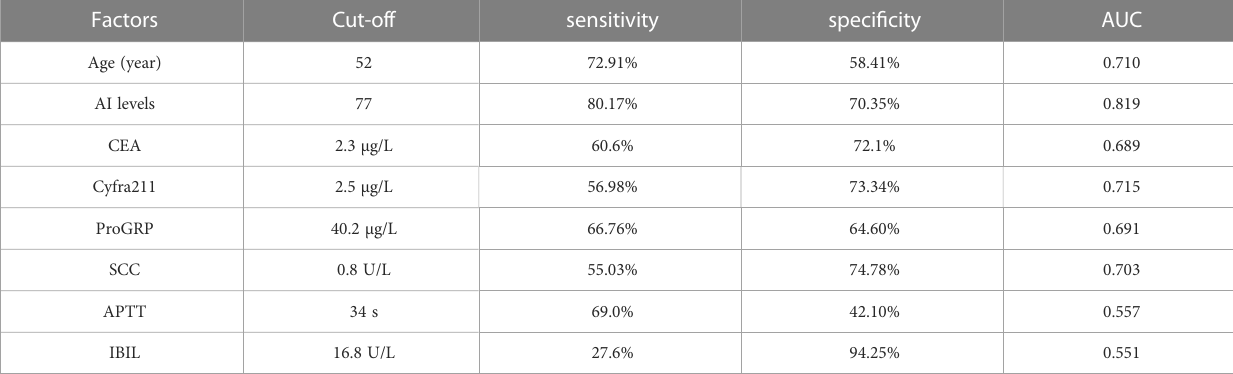
TABLE 3 The predicted value parameters of risk factors.